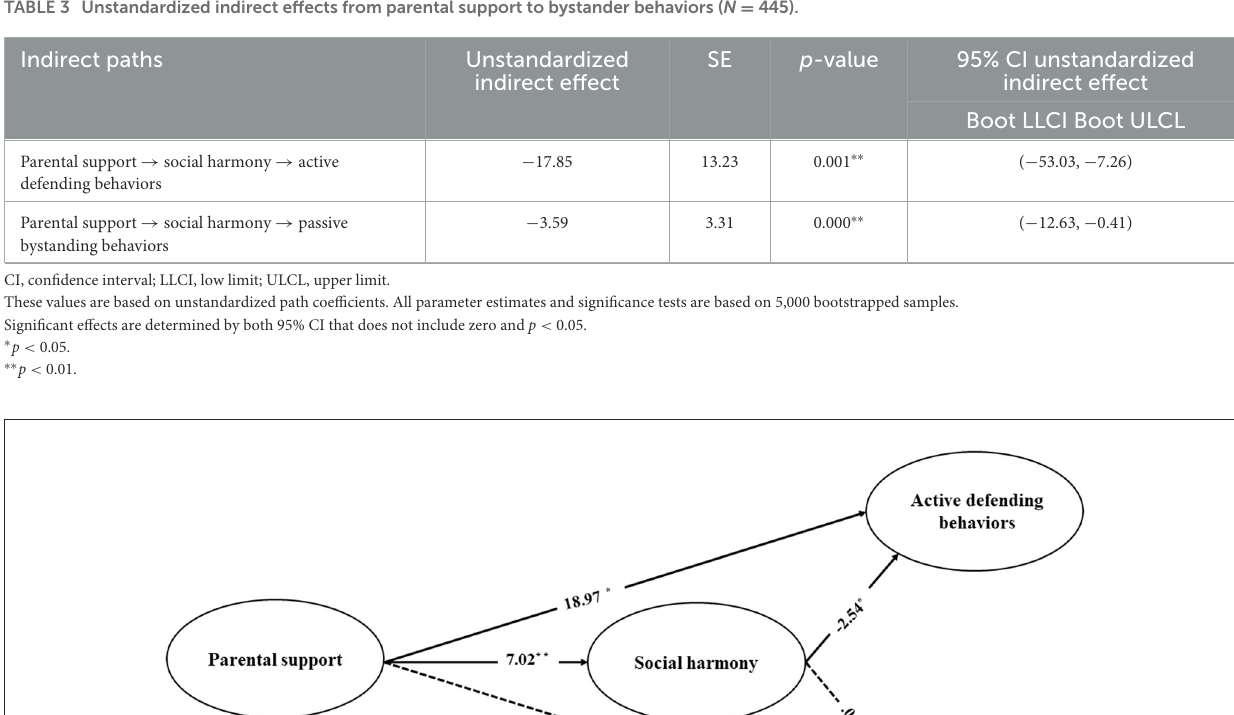
TABLE 3 Unstandardized indirect effects from parental support to bystander behaviors ( N = 445).